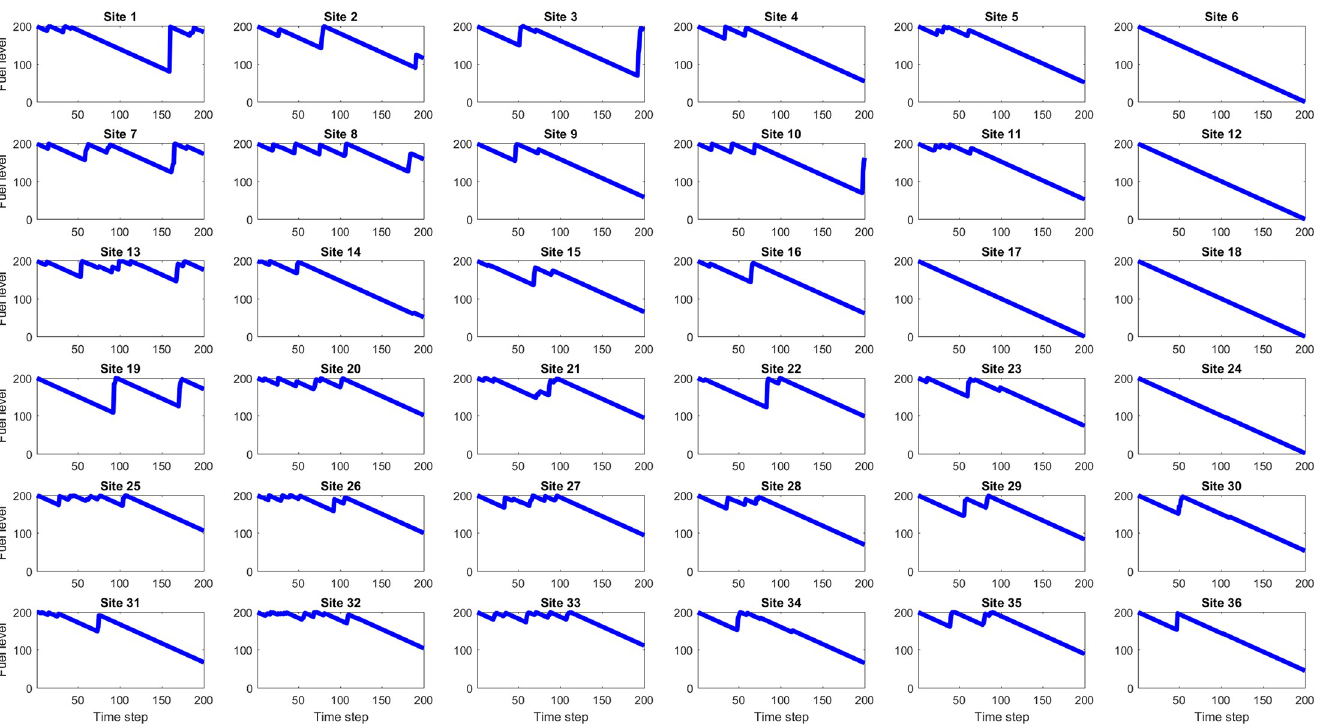
Fig 14. Time series of site fuel unit values, for 200 initial (and maximum) fuel units case. The simulation run times in this case are approximately twice as long as the 100 fuel unit case and consequently the assets have even more time to refuel sites, however it is seen that some site, such as 6, 12, 18, and 24, are still seldom or never